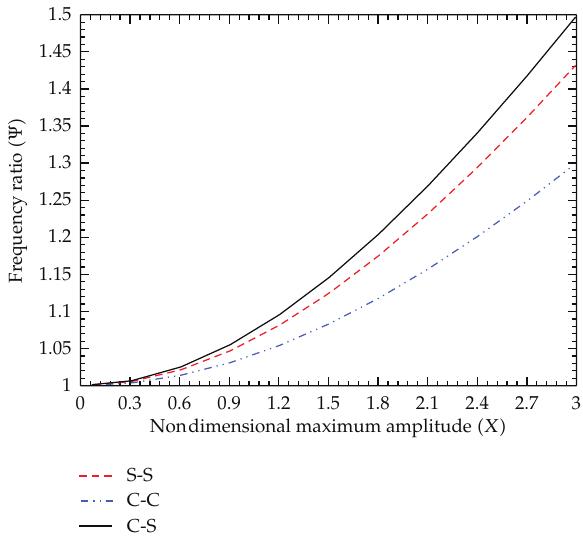
Figure 4: Nondimensional frequency ratio against nondimensional maximum amplitude of DWNTs under various boundary conditions (cid:3) k (cid:8) 10 7 N/m 2 (cid:4) .